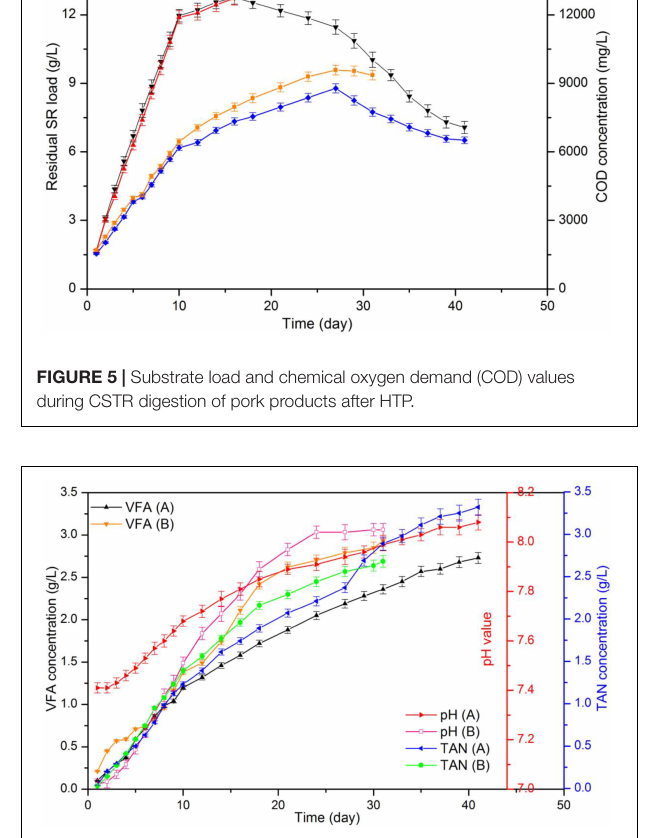
FIGURE 6 | pH and total ammonia nitrogen (TAN) concentration in VFA during CSTR digestion of pork products after